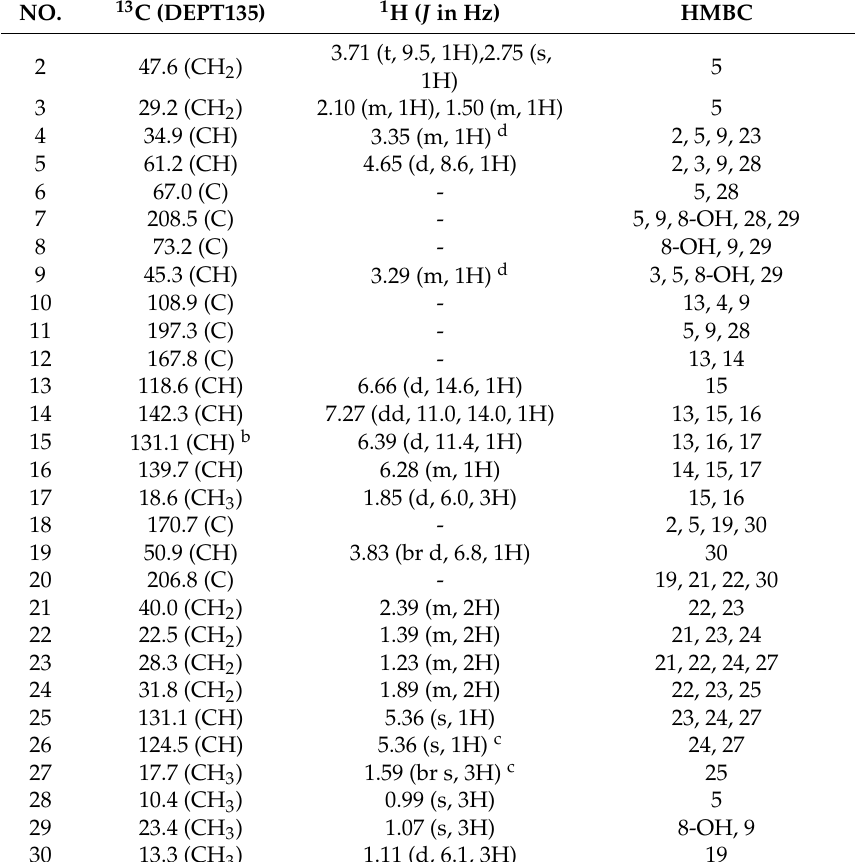
Table 1. The NMR data of compound 1 (100 MHz for 13 C and 400 MHz for 1 H in DMSO- d 6 ) a . NO. 13 C (DEPT135) 1 H ( J in